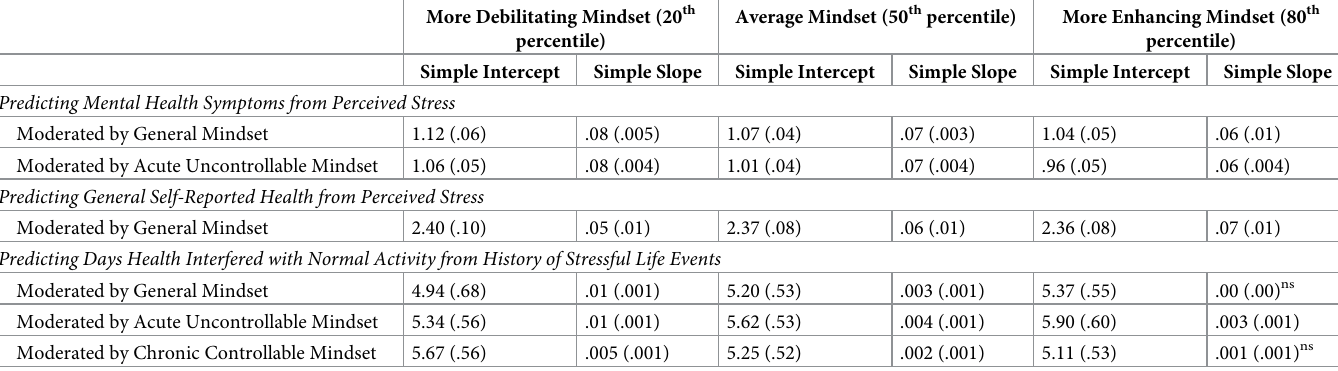
Table 5. Simple intercepts and simple slopes for significant interaction effects between stress measures and stress mindsets predicting